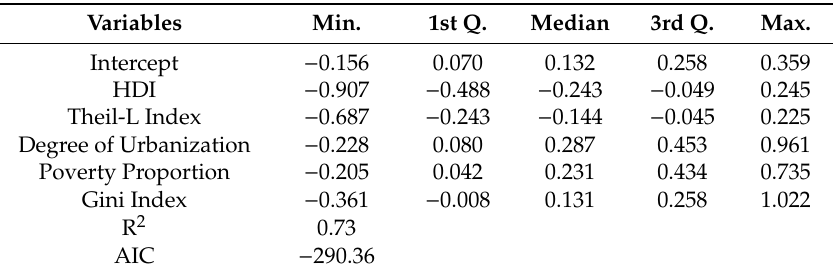
Table 3. Results of the GWR model for homicide rates.